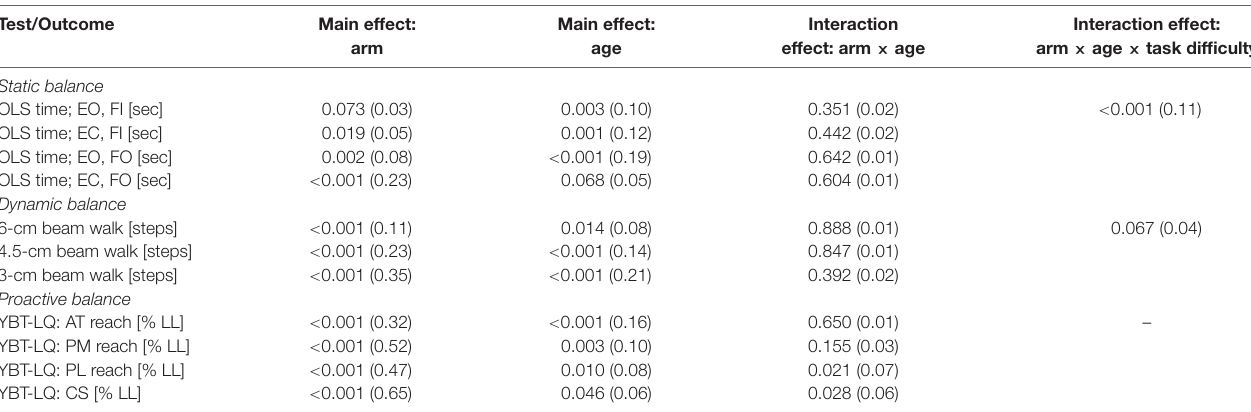
TABLE 2 | Main and interaction effects of the repeated measures ANOVA per outcome